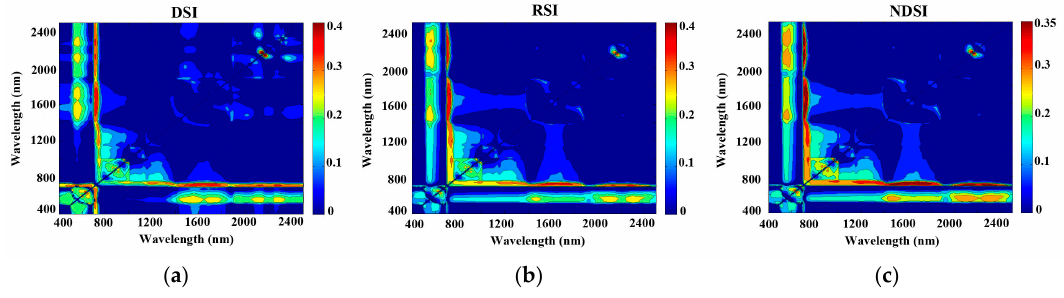
Figure 4. Contour maps of coefficients of determination for the linear relationship between the three vegetation indices (difference spectral index (DSI, a ), ratio spectral index (RSI, b ), or normalized difference spectral index (NDSI, c )) and chemically-measured leaf N concentration using the spectra measured by the black background.